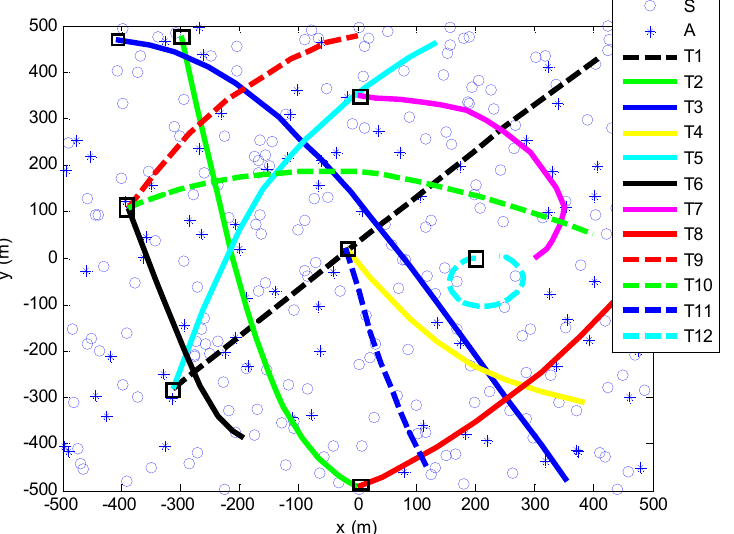
Figure 2. Target trajectories: small squares represent locations of target birth, and the line destination point represents the locations of target death, which are not labeled. The labels of S , A , and Tn are abbreviations of the normal sensor, anchor, and trajectory n, respectively.